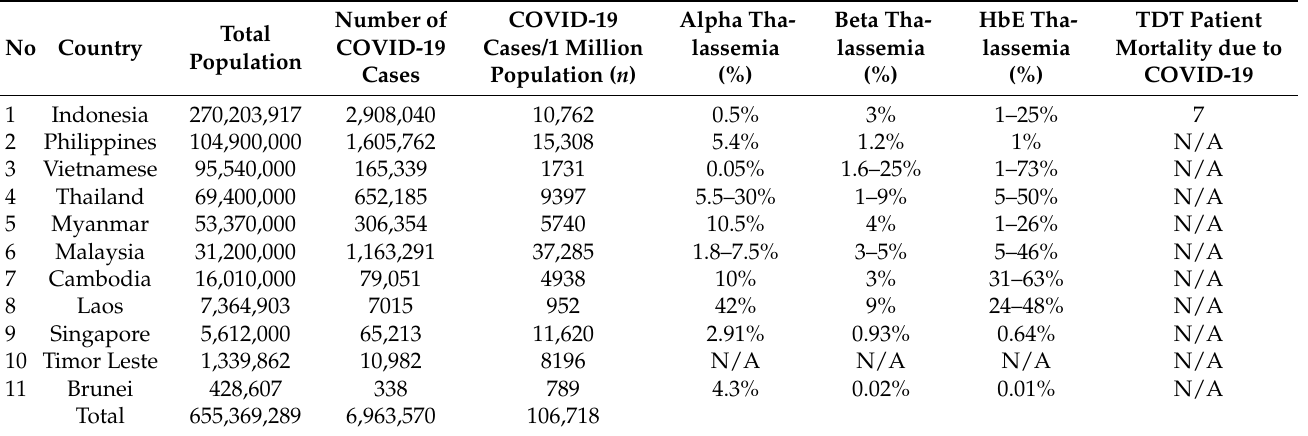
Table 4. Prevalence of COVID 19 and thalassemia in ASEAN countries